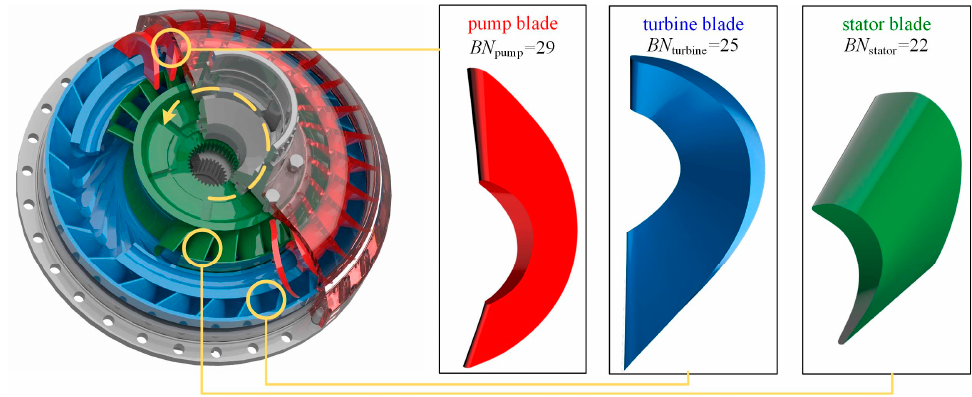
Figure 1. An anatomy diagram of a hydraulic torque converter.